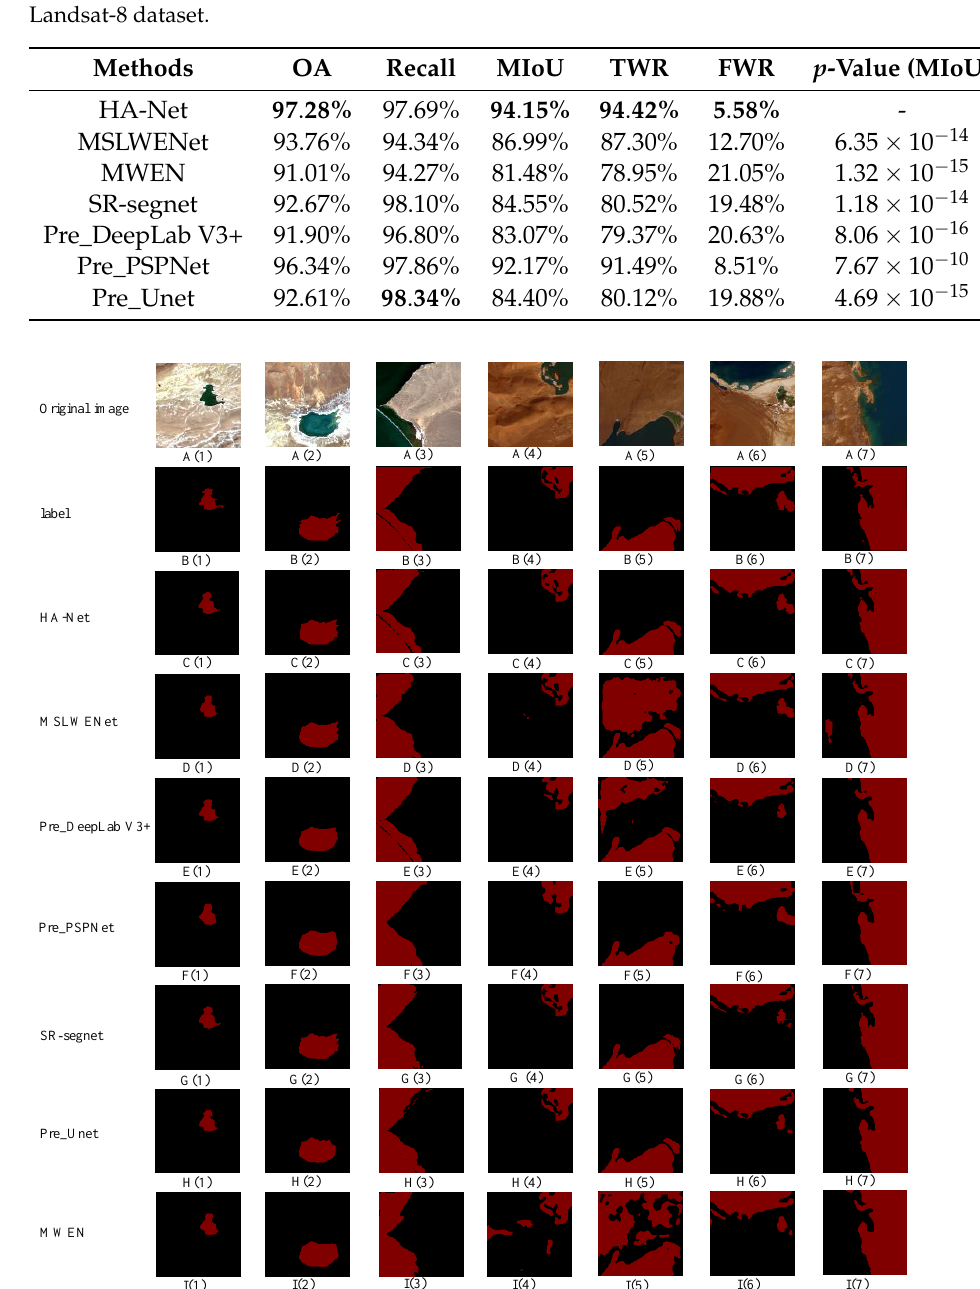
Figure 11. The visualization results of comparing the proposed method against other methods on the Landsat-8 dataset. ( A ( 1 )– A ( 7 )) are the raw images in the landsat-8 dataset; ( B ( 1 )– B ( 7 )) are the ground truths to which the raw images correspond; ( C ( 1 )– C ( 7 )), ( D ( 1 )– D ( 7 )), ( E ( 1 )– E ( 7 )), ( F ( 1 )– F ( 7 )), ( G ( 1 )– G ( 7 )), ( H ( 1 )– H ( 7 )), and ( I ( 1 )– I ( 7 )) are the extracted results of HA-Net, MSLWENet, Pre_DeepLab V3+, Pre_PSPNet, SR-segnet, Pre_Unet, and MWEN,